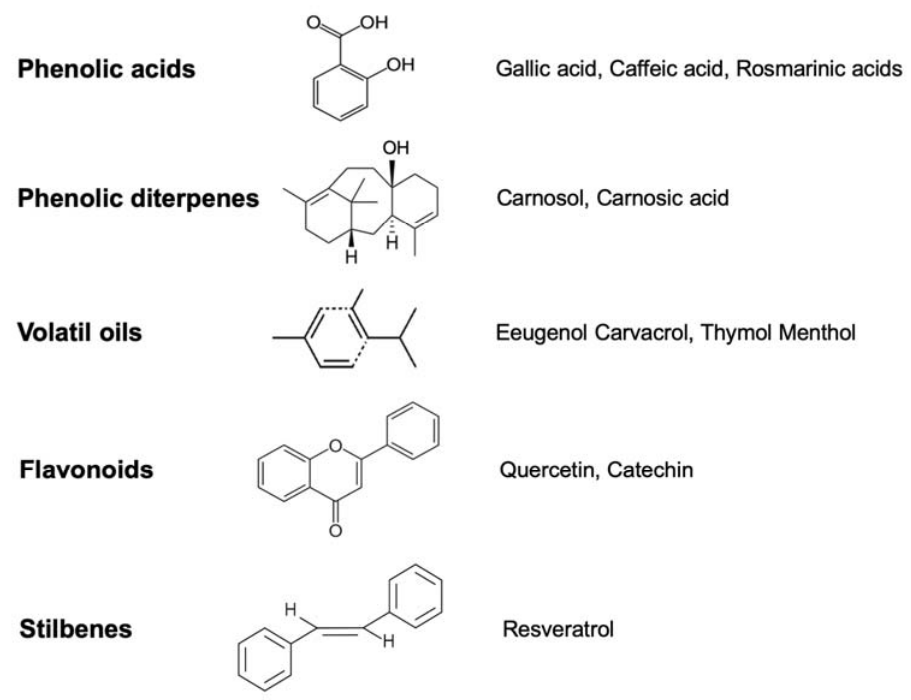
Figure 1. Typical representatives of antioxidant polyphenol classes with their basic chemical structure.